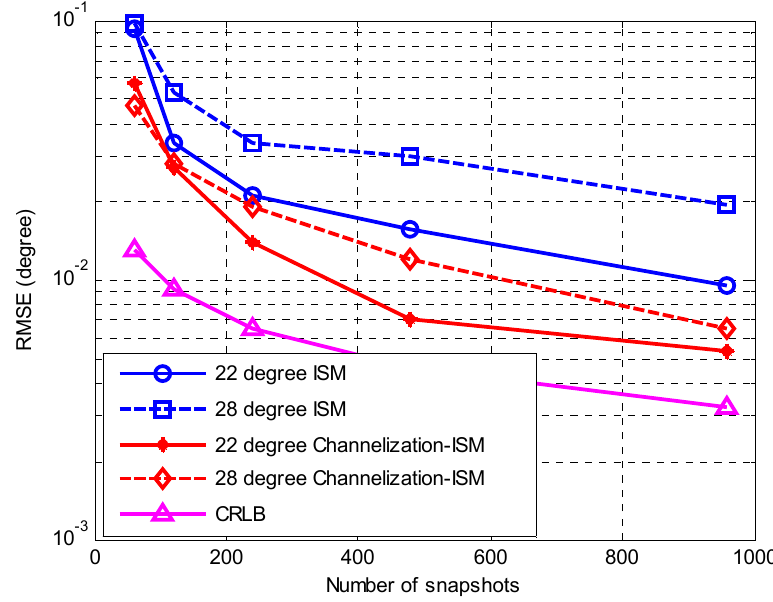
Figure 4. RMSE of the DOA estimates against the number of snapshots.